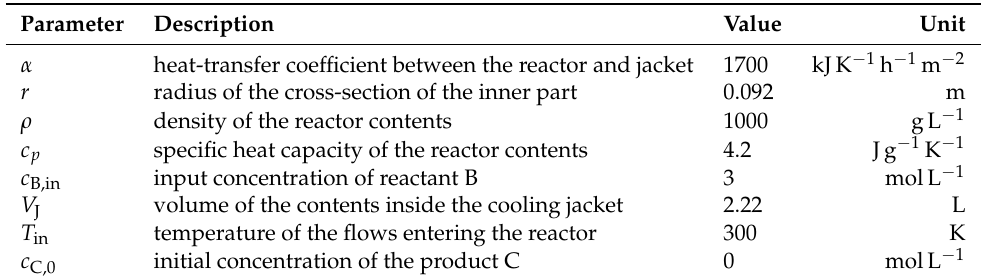
Table 2. Case study 1: Model parameters.